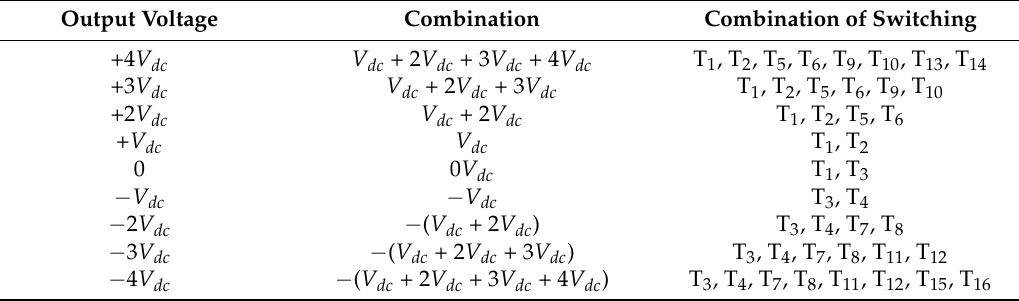
Table 2. PV system based 9-level single phase CHB-MLI switching scheme.